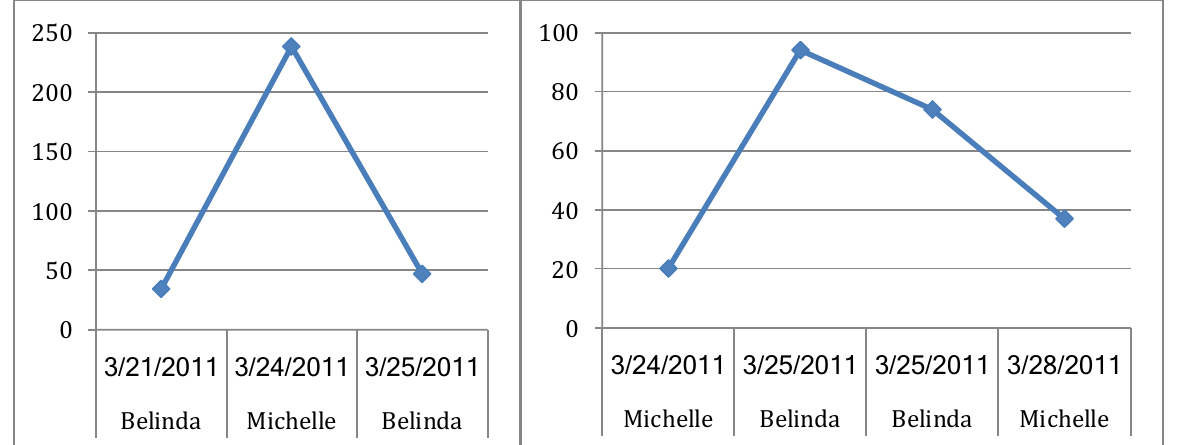
Evolution of the Texas (left) and China (right) topics by word count